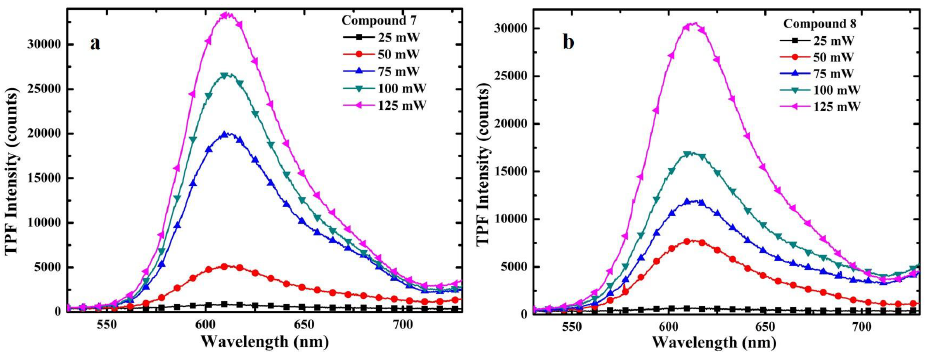
Figure 1. TPF spectra ( a ) for compound 7 and ( b ) for compound 8 .